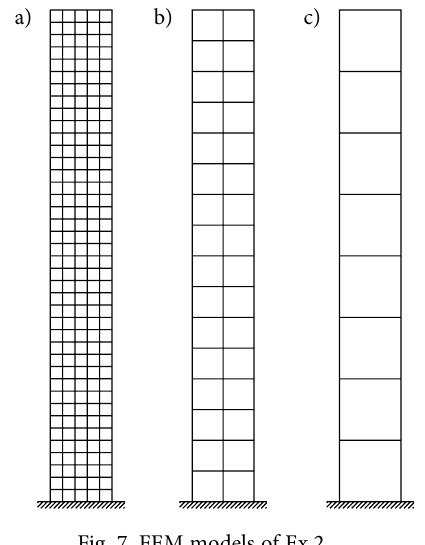
Fig. 7. FEM models of Ex.2